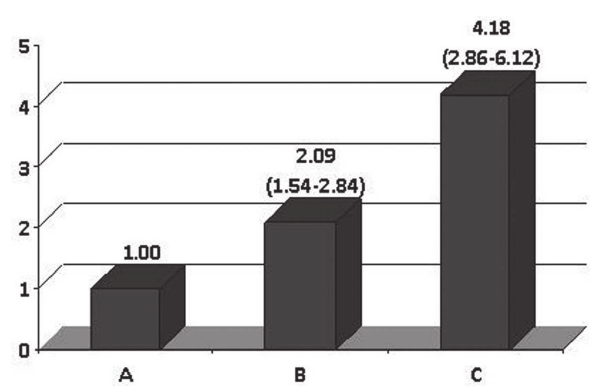
Fig. 5 - Pacientes do grupo B apresentaram um risco relativo (RR) de mortalidade intra-hospitalar de 2,09 (CI95%:1,54-2,84) comparados aos do grupo A. Os do grupo C apresentaram um RR de 4,18 comparados ao grupo A (CI95%: 2,86-6,12)